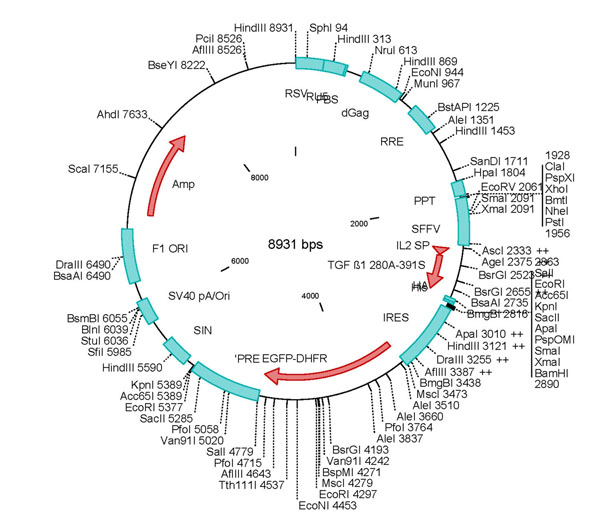
TGFb-1 vector used for the lentiviral transduction of CHO cell line (CHOSFS).